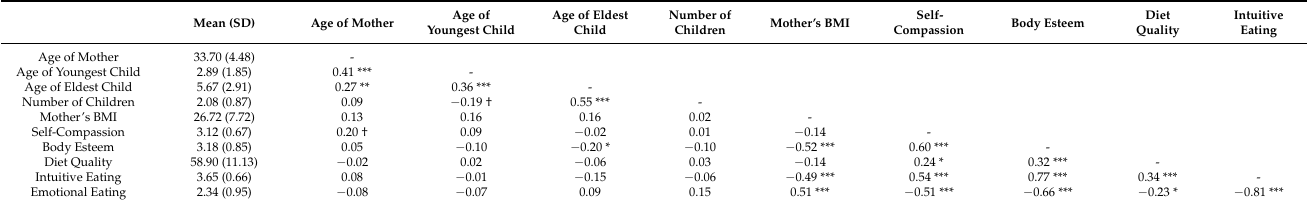
Table 1. Descriptive statistics and Pearson’s correlations for the study variables.